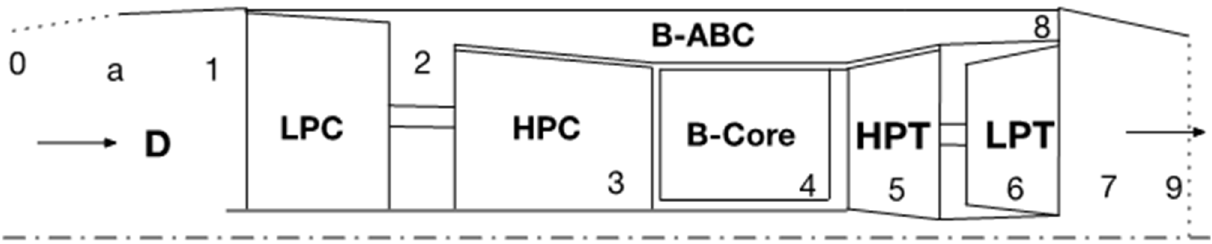
Figure 3. TurboAux